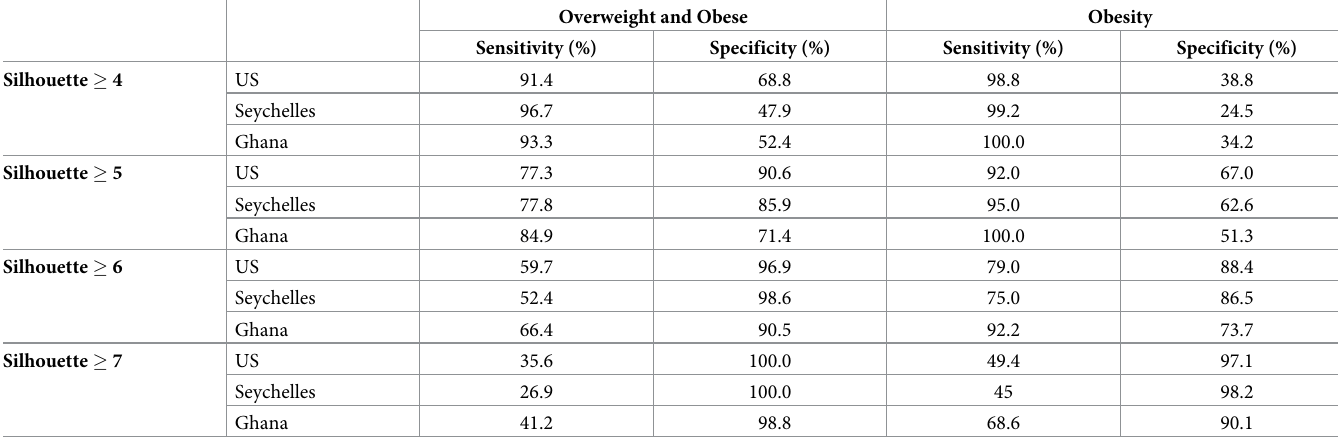
Table 4. Sensitivity and specificity of self-selected silhouette ratings to detect overweight and obesity, or obese only in US, Seychelles, and